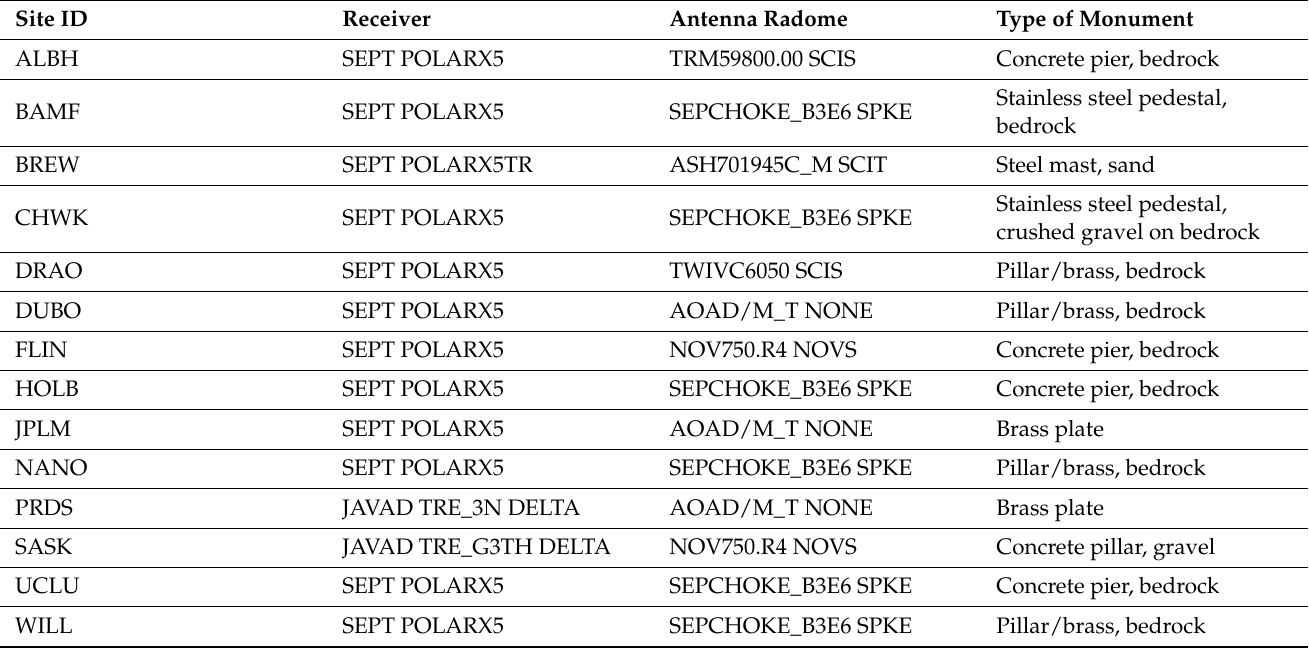
Table 5. Station information of the selected CRTN CORS